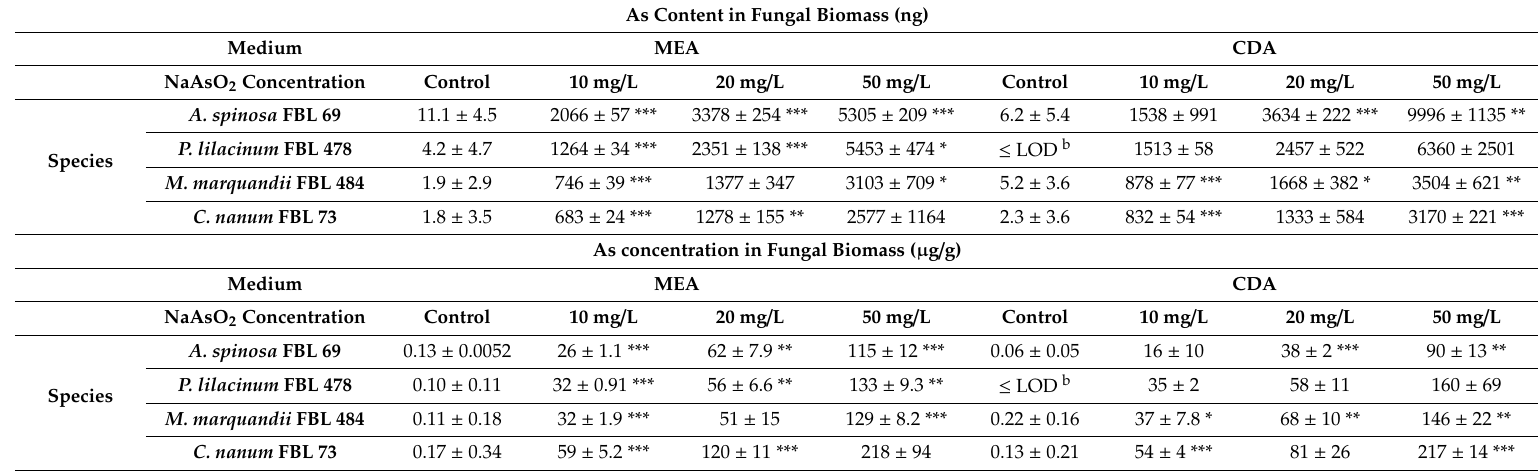
Table 5. As content and As concentration in the tested species’ fungal biomass after growth of the fungal species for seven days at 25 ◦ C. Data are expressed as the mean ± standard deviation of independent biological replicates a .